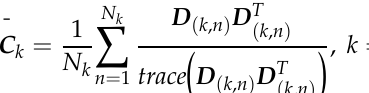
Figure 2. The processing flow of the proposed method.